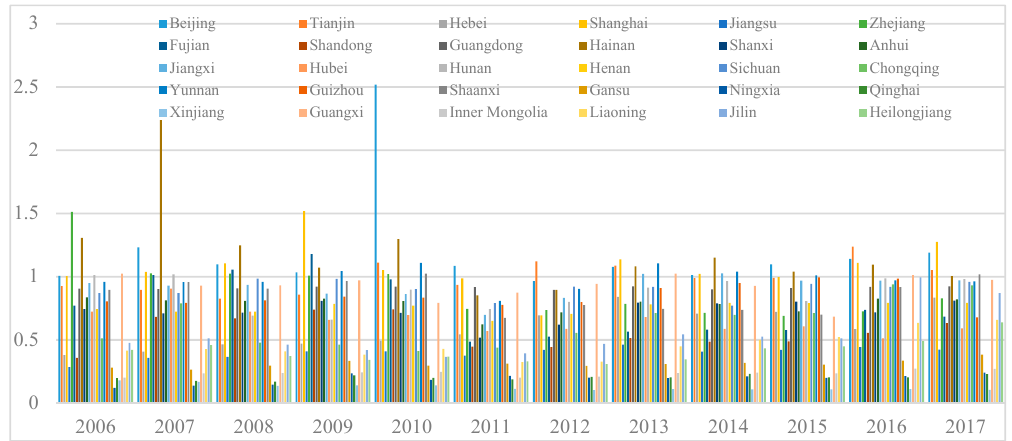
Figure 3. The EWP of the 30 Chinese provinces from 2006 to 2017.